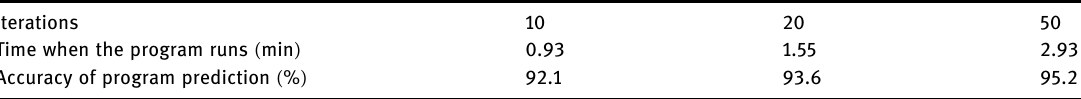
Table 1: Operational performance of hemorrhoids with di ff erent iteration times Iterations Time when the program runs ( min